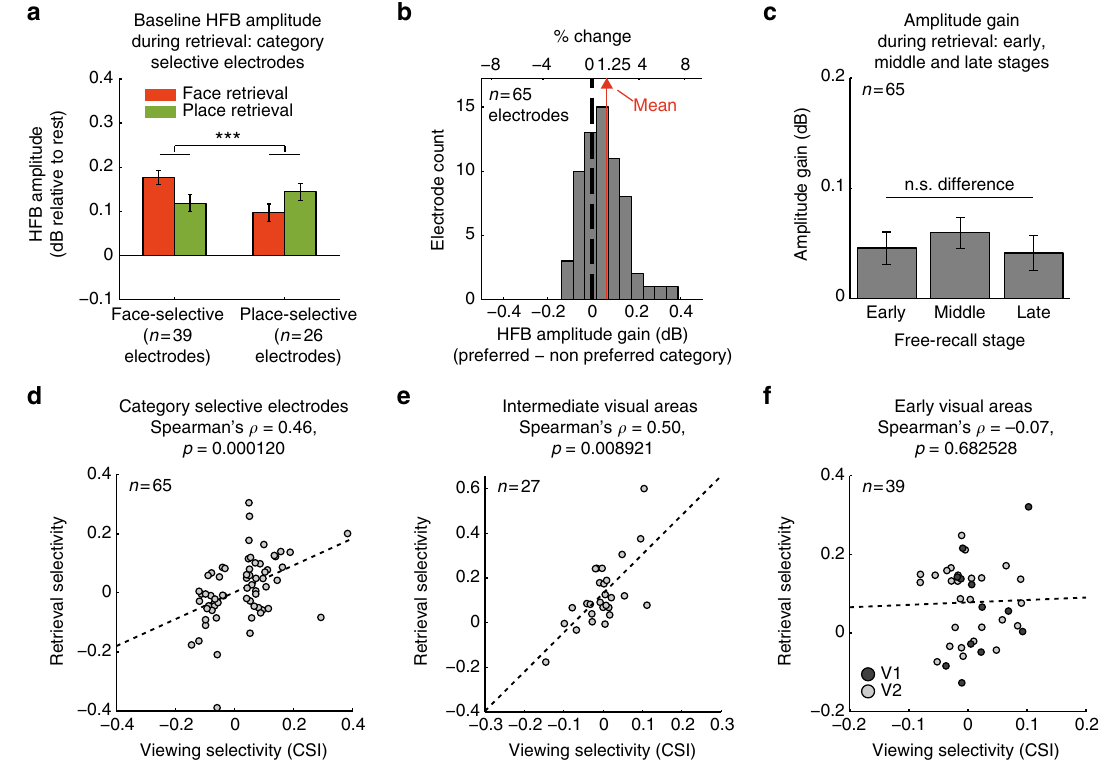
Fig. 3 Content-selective baseline shifts during free recall — group results. a Median HFB amplitude in category selective electrodes was increased in a content-selective manner throughout the free recall period (two-way mixed-effects ANOVA, interaction: F(1,63) = 17.69, *** p < 0.0001). b A histogram showing HFB amplitude gain during recall across all category selective electrodes: preferred minus non-preferred category, p < 0.0001, signed-rank test. c HFB amplitude gain during early, middle and late recall stages: preferred minus non-preferred category. There was no signi fi cant difference between the three stages ( p = 0.15, one-way repeated measures ANOVA). d − f Correlation between category-selectivity index (CSI) during viewing and baseline-shift selectivity during recall (all category selective electrodes: Spearman ’ s ρ = 0.46, p = 0.0001; intermediate visual areas: Spearman ’ s ρ = 0.50, p = 0.009; V1 and V2: Spearman ’ s ρ = − 0.07, p > 0.68). In contrast to high visual areas, early visual electrodes did not show any correlation. Error bars represent